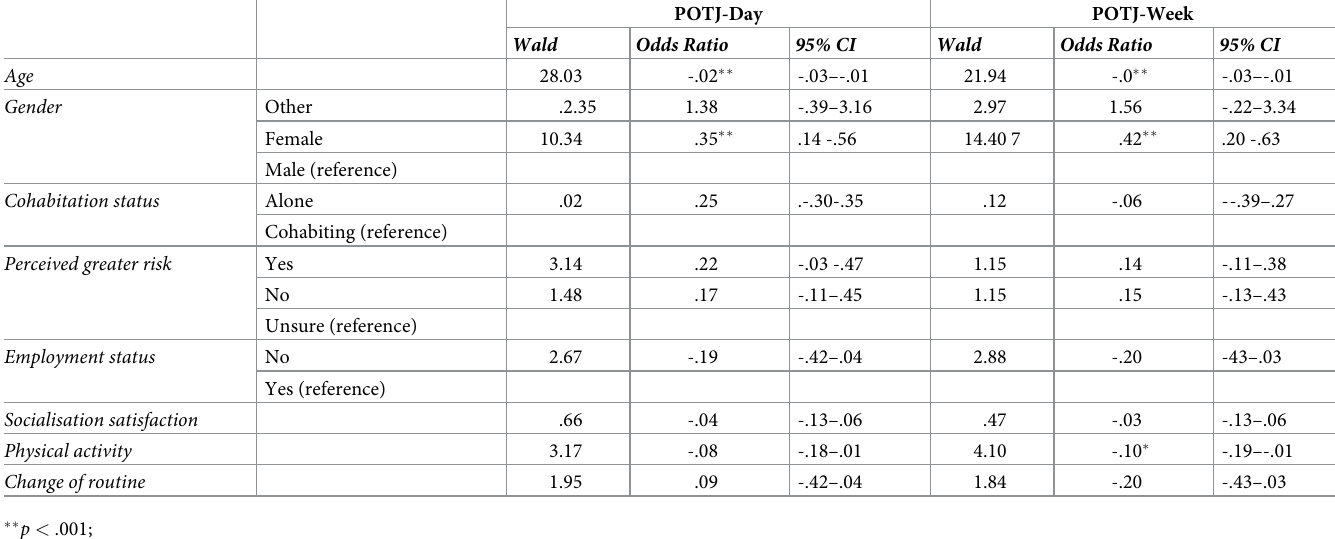
Table 5. Wald, odds ratios and 95% confidence intervals from the ordinal regressions for POTJ-day and